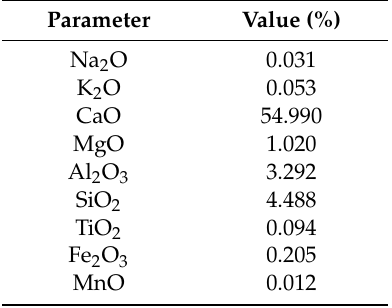
Table 3. Chemical analysis of the paper